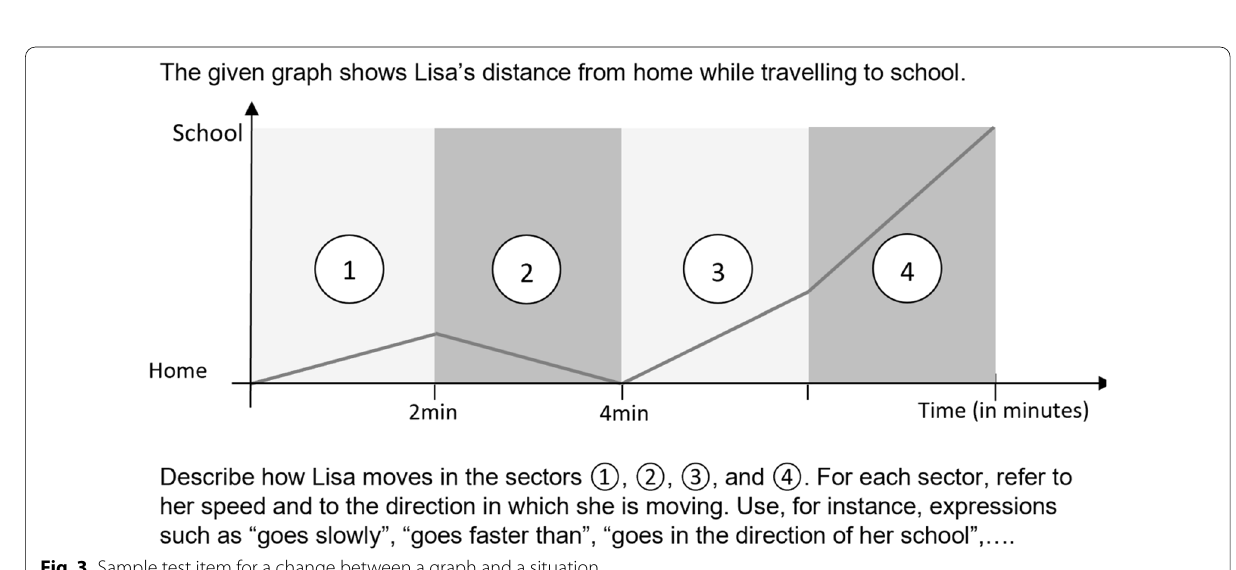
Fig. 3 Sample test item for a change between a graph and a situation